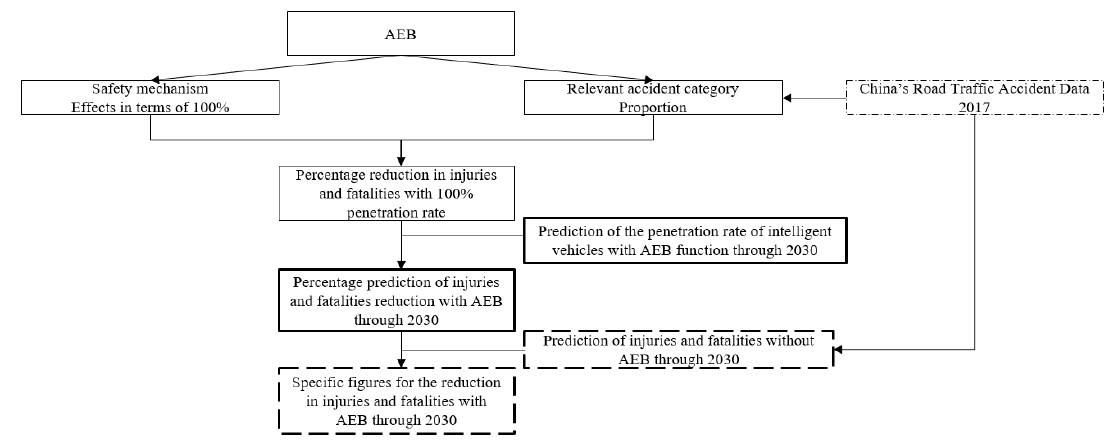
Figure 1. Evaluation model used in this study.